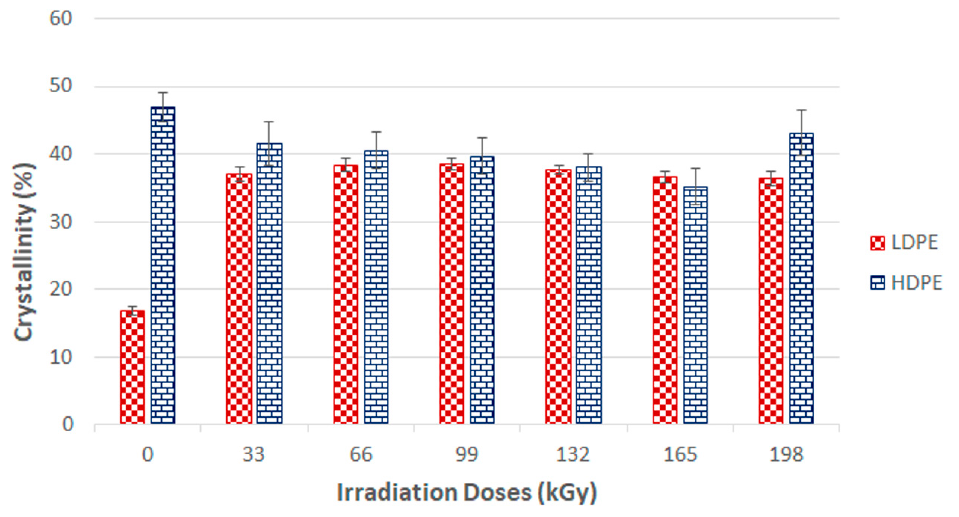
Figure 20. X-ray diffraction crystallinity of irradiated LDPE and HDPE; the vertical line drawn at the top of the column represents the standard